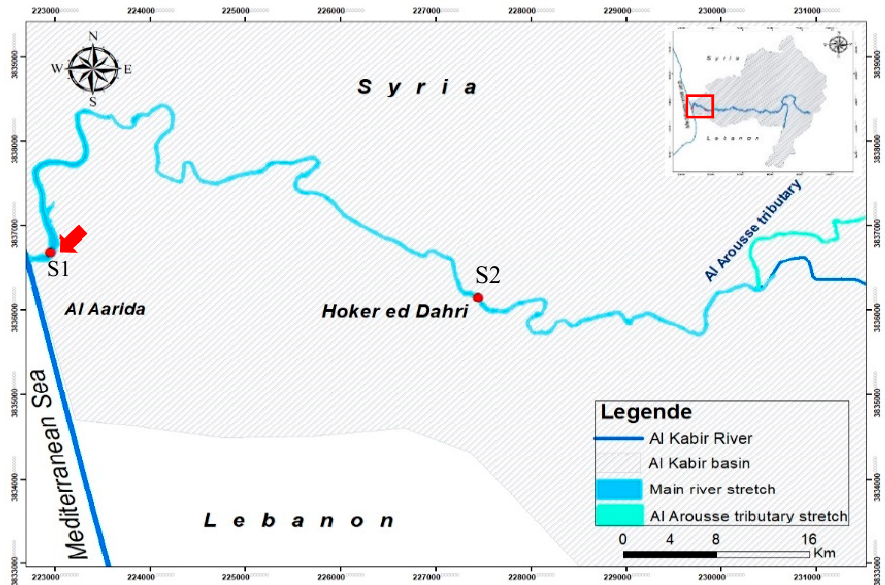
Figure 1. Al Kabir watershed and the study area. The red arrow indicates the two consecutive sectors used to distinguish water hyacinth and riparian vegetation cycles.